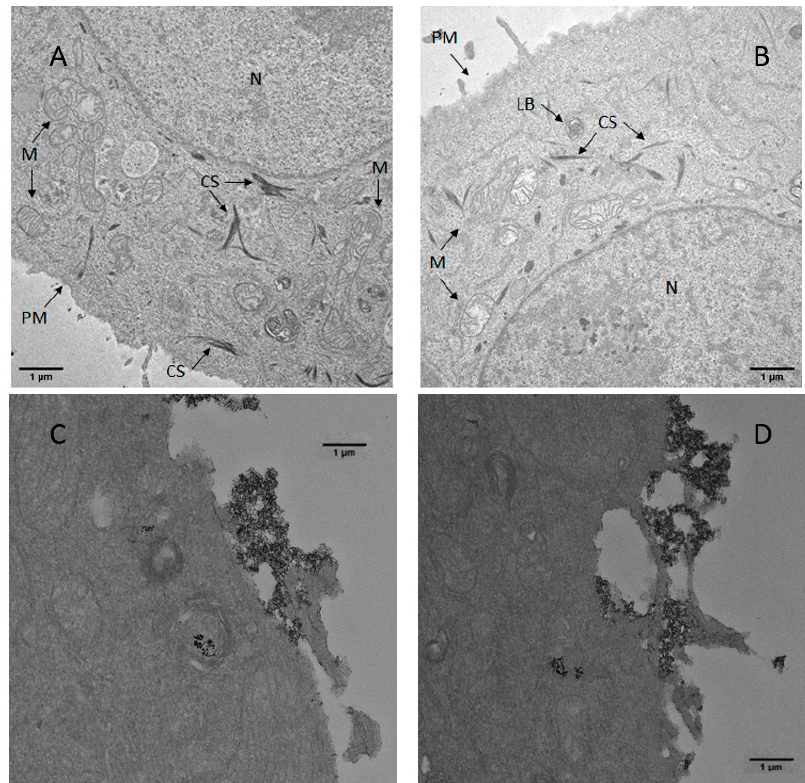
Figure A6. TEM picture of A549 exposed to AgPVP ( B ) or AgHECp ( C , D ) NPs. Increased membrane localization of NPs is evident in AgHECp treated cells and intracellular localization in lamellar bodies ( C ) in compared to AgPVP ( B ) and control cells ( A ). M = mitochondria, PM = plasma membrane, LB = lamellar bodies, CS = cytoskeleton, and N = nucleus.